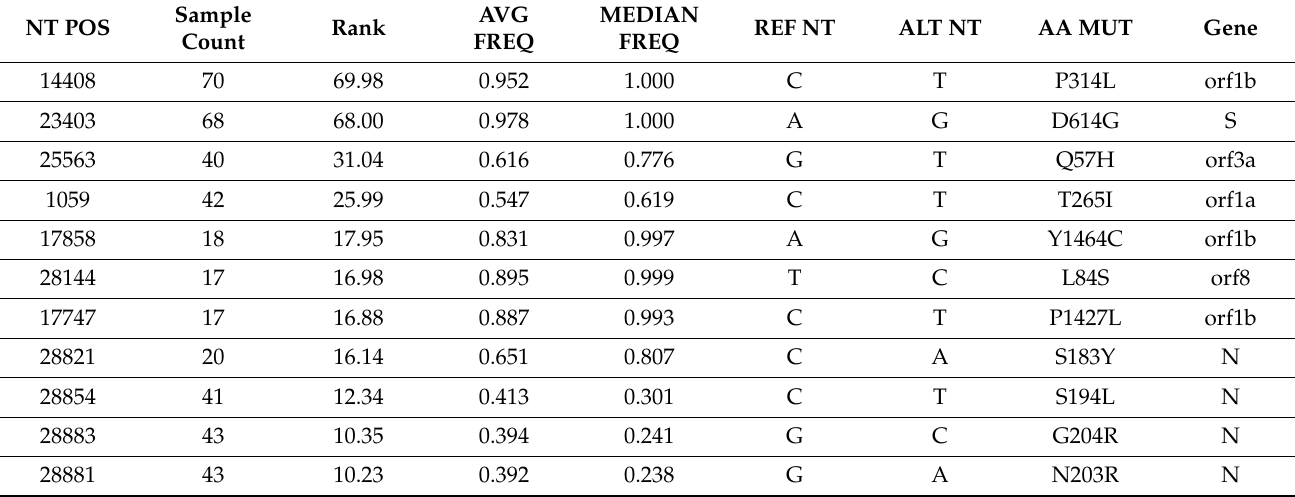
Table 1. Top 10 mutations as ranked according to sample count and frequency. Mutations were ranked by multiplying the sample count by the median detection frequency. N protein mutations R203K and G204R are considered co-occurring. NT POS: nucleotide position; SAMPLE COUNT: number of samples with the mutation; AVG FREQ: average frequency; MED FREQ: median frequency; REF NT: nucleotide in the reference sequence; ALT NT: nucleotide in the sample sequence; AA MUT: residue number in the gene with the amino acid mutation and the amino acid